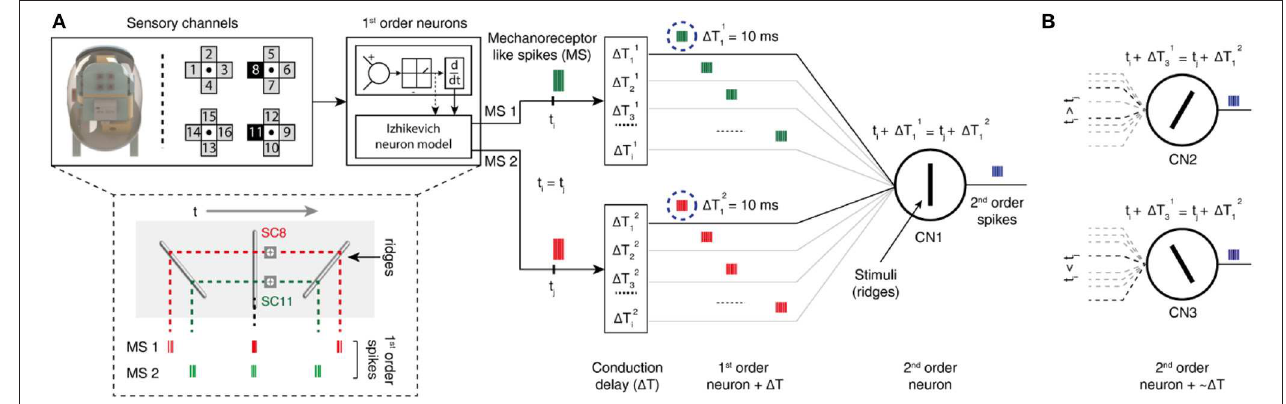
FIGURE 2 | Two-layer neuron architecture. (A) ( Left ) fingertip structure and arrangement of 16-sensory channels. The data from two sensory channels (8 and 11) are injected as input current into the Izhikevich neuron model (1st order neurons), that deliver mechanoreceptor-like spike trains. ( Below ) representative illustration of mechanosensors responses [MS1 and MS2 (corresponding to SC8 and SC11 respectively)] to ridges having an angle of − 45 ◦ , 0 ◦ , and 45 ◦ relatively to the direction orthogonal to stimulus-finger relative motion. ( Right ) schematic diagram of second order neuron implementation for edge orientation processing. Two different mechanosensors inputs (green and red spike trains, MS1, and MS2) for a single stimulation sequence converge to the same cuneate nucleus neuron (CN i , 2nd order neuron), through specific conduction delays along the pathway. In the illustrated example, CN1 generates output spikes (blue spike trains) only when it receives MS inputs that coincide. (B) The other CNs (CN2 and CN3) respond to different angle stimuli, depending on the set of conduction delays and subsequent temporal relations formed between the